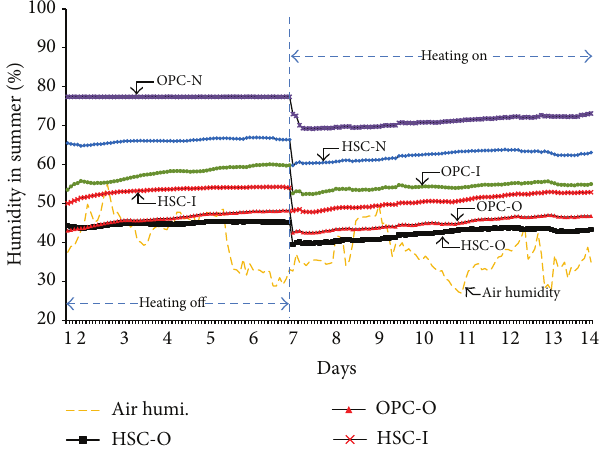
Figure 10: Measurement results of the interior humidity in